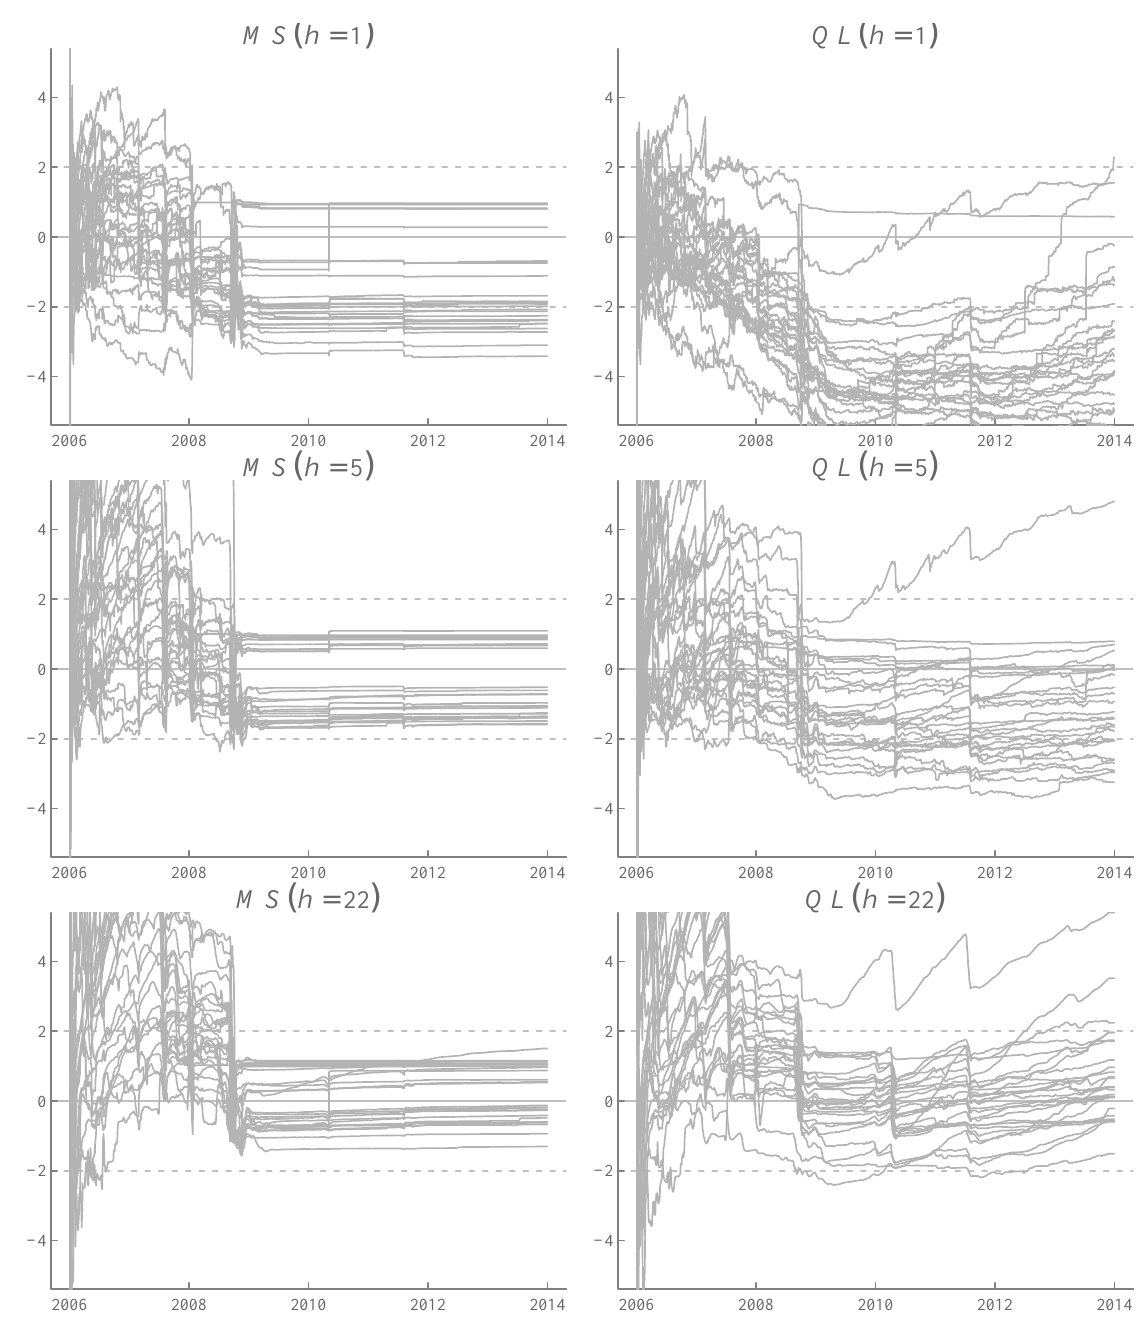
Figure A6. Running t -ratios of Diebold and Mariano [27] test of equal predictive accuracy of h -step RV rolling forecasts. Each panel has 27 lines for the 27 stocks in the sample. The baseline forecast is from the HARQ model (no transformation) and the comparison forecast is a simple exponential transform of the log forecast from model (Section 3.1). A positive value indicates better forecast from the comparison model against the baseline HARQ forecasts. MS for equality of mean squared error loss and QL for QLIKE loss of Patton [24]. The rolling forecasts are generated with a rolling estimation window of 8.67 years (104 months) followed by a one month prediction window shifted each month over 96 windows. The forecast sample is from 3 January 2006 to 31 December 2013 (2013 trading